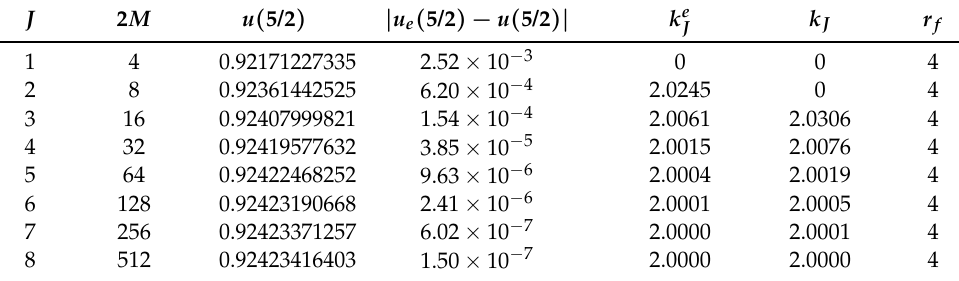
Table 7. Solutions to (24) where u e ( 1/2 ) = 0.9242343145 using